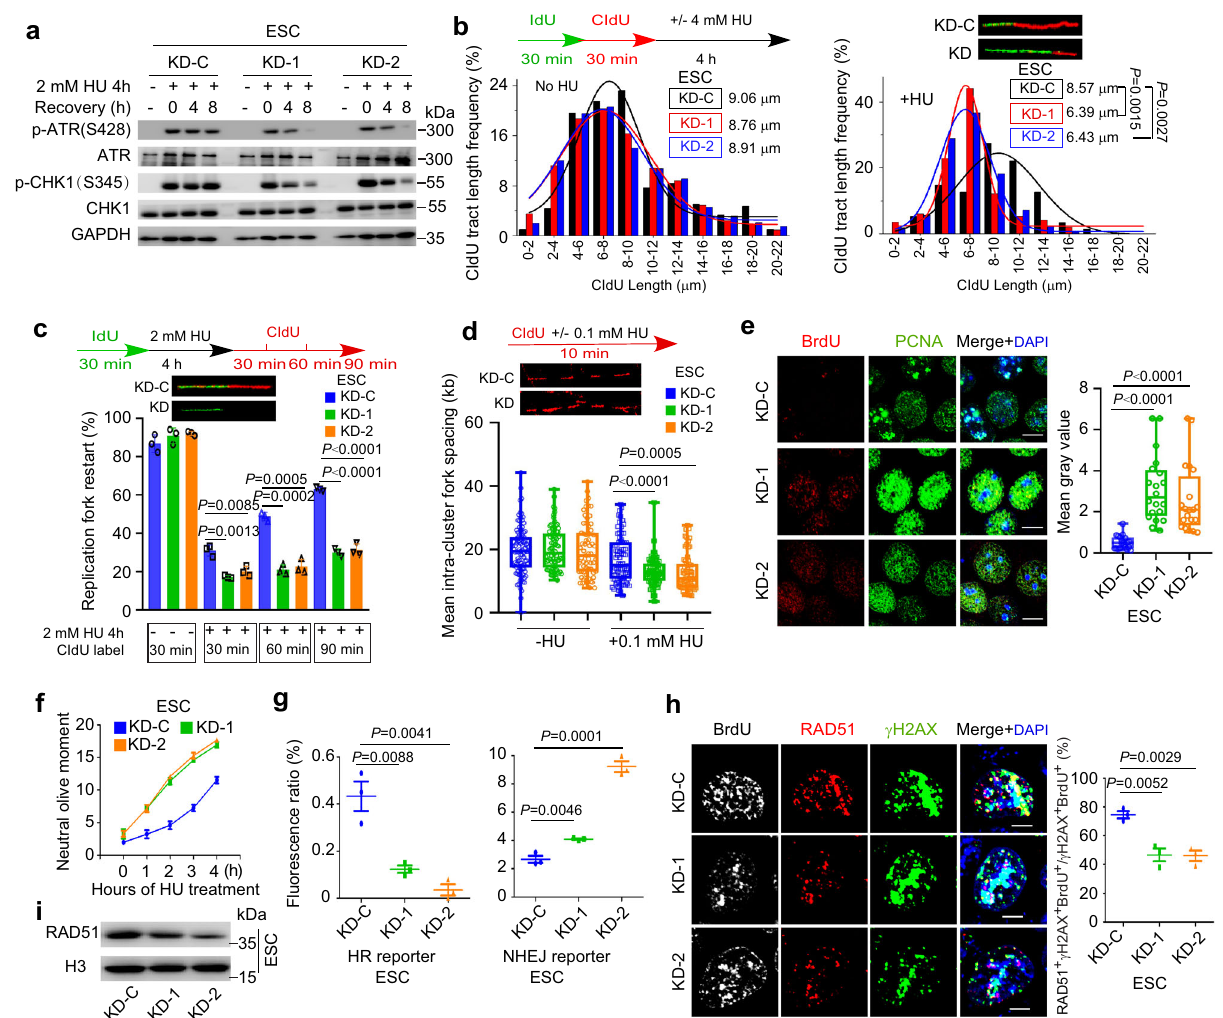
Fig. 2 Discn regulates DNA replication stress response and HR-mediated DNA DSB repair. a Mouse ESCs were treated with hydroxyurea (HU) to induce replication stress. ATR-CHK1 kinase activation failed to be well sustained in two Discn knockdown cells (KD-1 and KD-2) when compared to the knockdown control (KD-C). Three independent experiments were repeated with similar results. b DNA fi ber assay revealed that the stalled forks in Discn KD cells were prone to undergo degradation after HU treatment. 200 fi bers from three independent replications were analyzed. c Discn KD compromised the stalled fork restart. At least 200 fi bers from three independent replications were analyzed. d Discn KD enhanced dormant origin fi ring as indicated by the reduced mean fork spacing. At least 50 continuous fi bers from three independent replications were analyzed. e Discn KD increased the content of ssDNA as measured by the native BrdU incorporation assay at S phase. Scale bar, 10 μ m. Quanti fi cation is shown on the right. At least 20 images were analyzed in each condition. f Compared to control ESCs (KD-C), Discn KD cells were more sensitive to hydroxyurea treatment and accumulated more DNA DSBs as measured by neutral comet assay. Data were from three replications and shown as mean ± SEM. g FACS analysis of reporter ESCs showed that Discn KD suppressed HR-mediated DNA DSB repair, but inversely stimulated NHEJ repair pathway. Data were from three independent experiments. h DNA DSBs were generated by laser microirradiation. Discn KD impaired the recruitment of Rad51 to DSB sites labeled with γ H2AX at S phase (BrdU + ), indicating the suppression of HR pathway. Right panel showed the proportions of S phase cells capable of HR repair (three replicates, 50 cells in each replicate). Scale bar, 5 μ m. i Immunoblotting showed a decrease in chromatin-bound Rad51 in Discn KD ESCs synchronized at S phase. Three independent experiments were repeated with similar results. b , c , f – h Data were shown as mean ± SEM, two-tailed Student ’ s t -test. d , e Data were representative of individual values with box and whiskers plots showing the median, upper and lower quartiles, and minimum and maximum. Two-tailed Student ’ s t